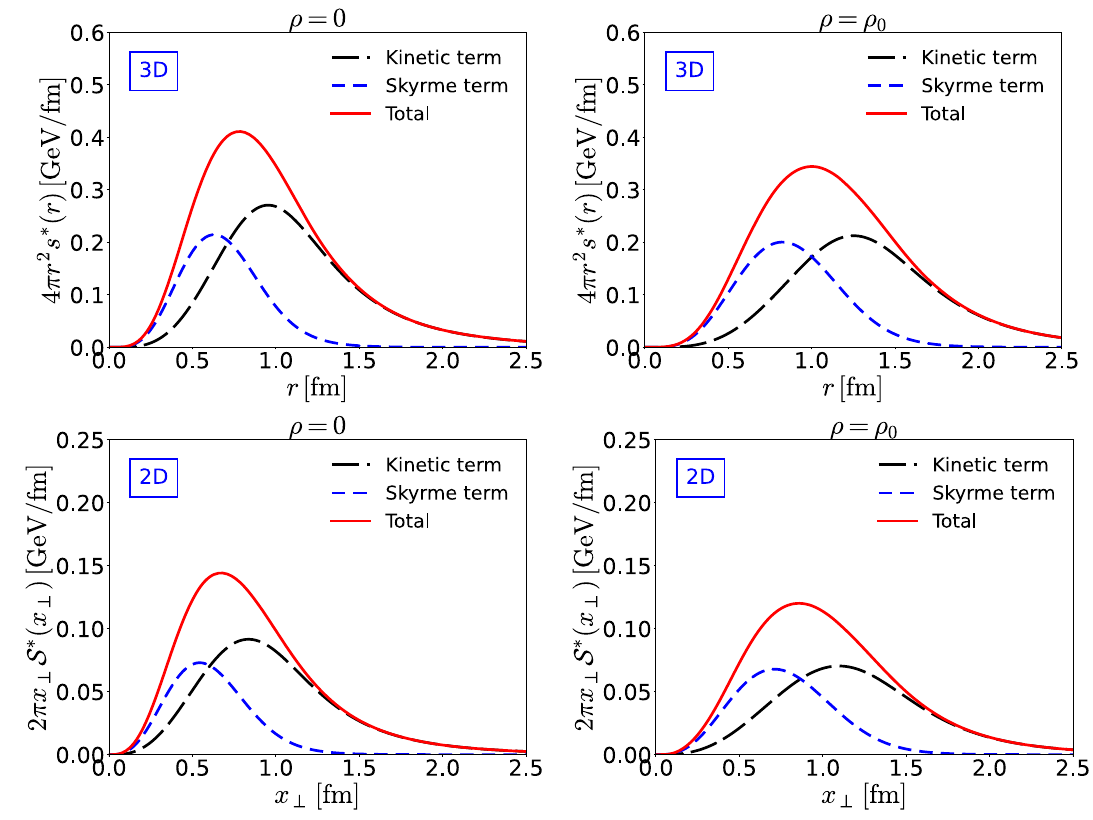
Fig. 6 3D and 2D shear-force distributions of the nucleon. The upper left (right) panel depicts the 3D shear-force distributions multiplied by 4 π r 2 at ρ = 0 ( ρ = ρ 0 ). The lower left (right) panel draws the 2D shear-force distributions with 2 π x ⊥ at ρ = 0 ( ρ = ρ 0 ). Notations are the same as in